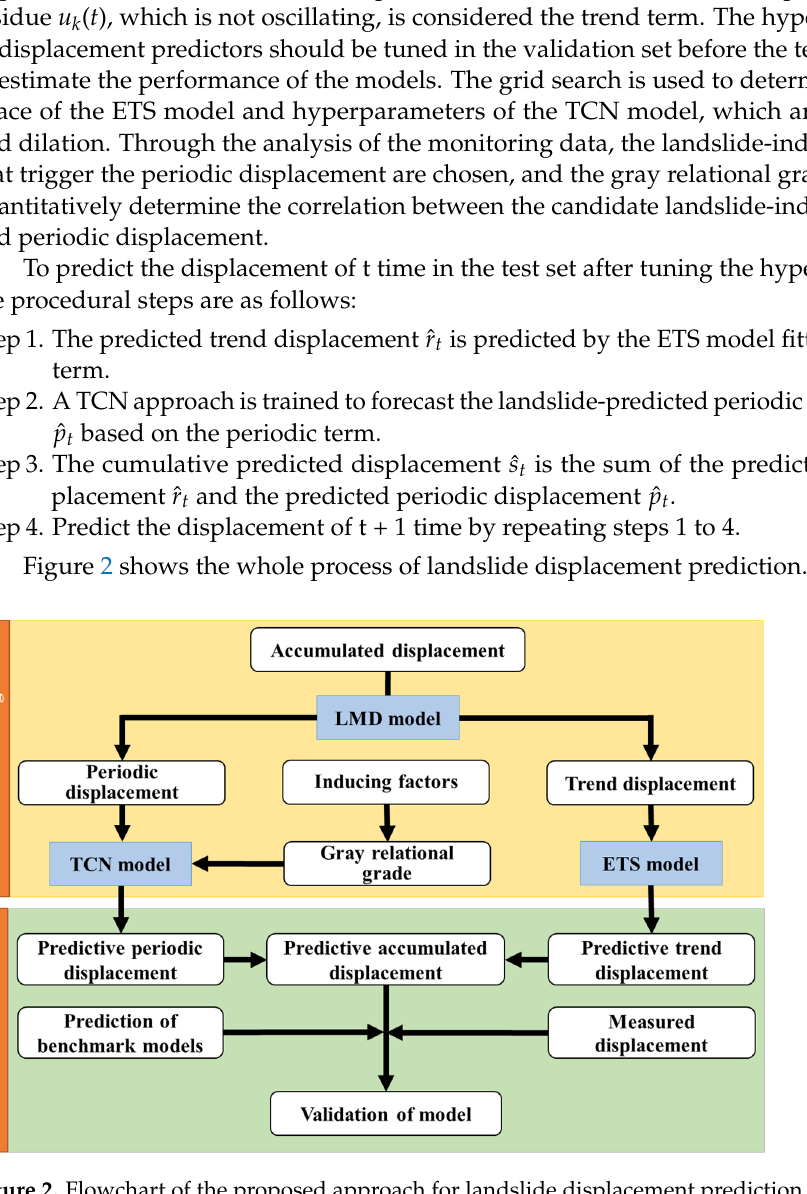
Figure 2. Flowchart of the proposed approach for landslide displacement prediction.